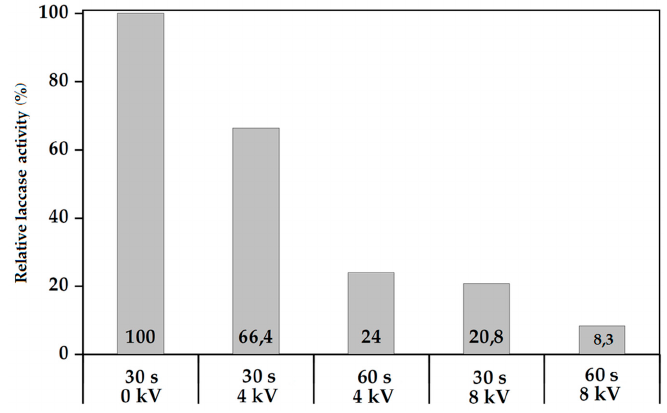
Figure 4. Experiment No. 1: Relative laccase activity (%) versus different applied voltages and plasma exposure times at constant V He = 10 L/min.